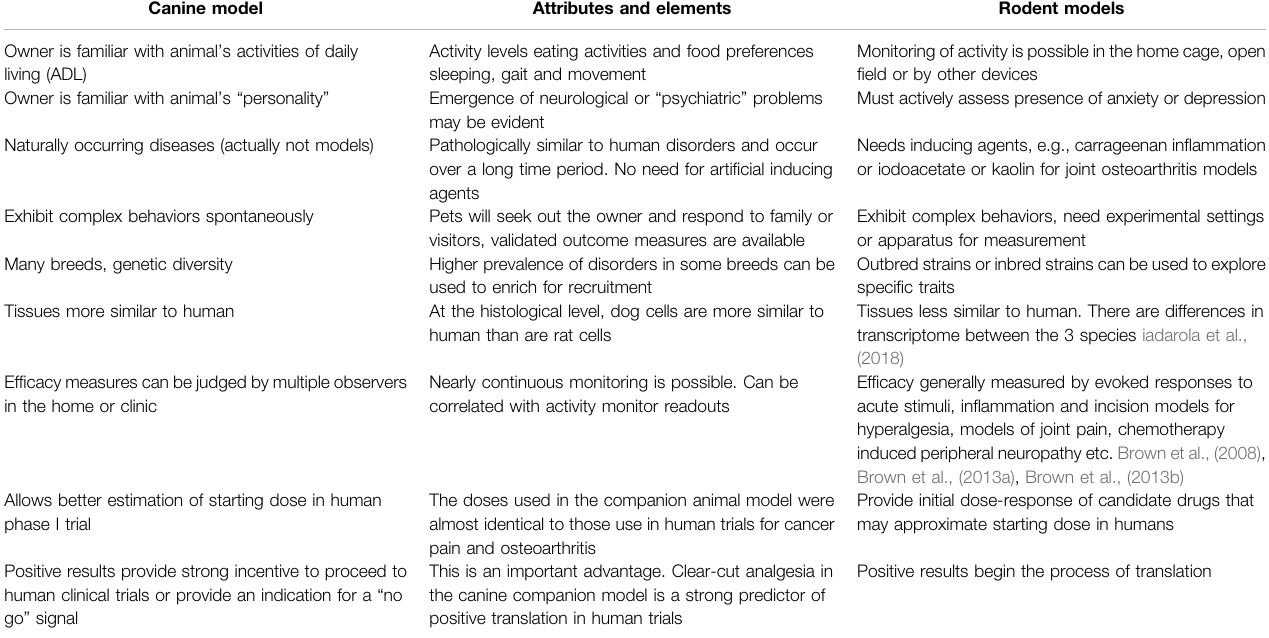
TABLE 1 | Advantages of companion animal